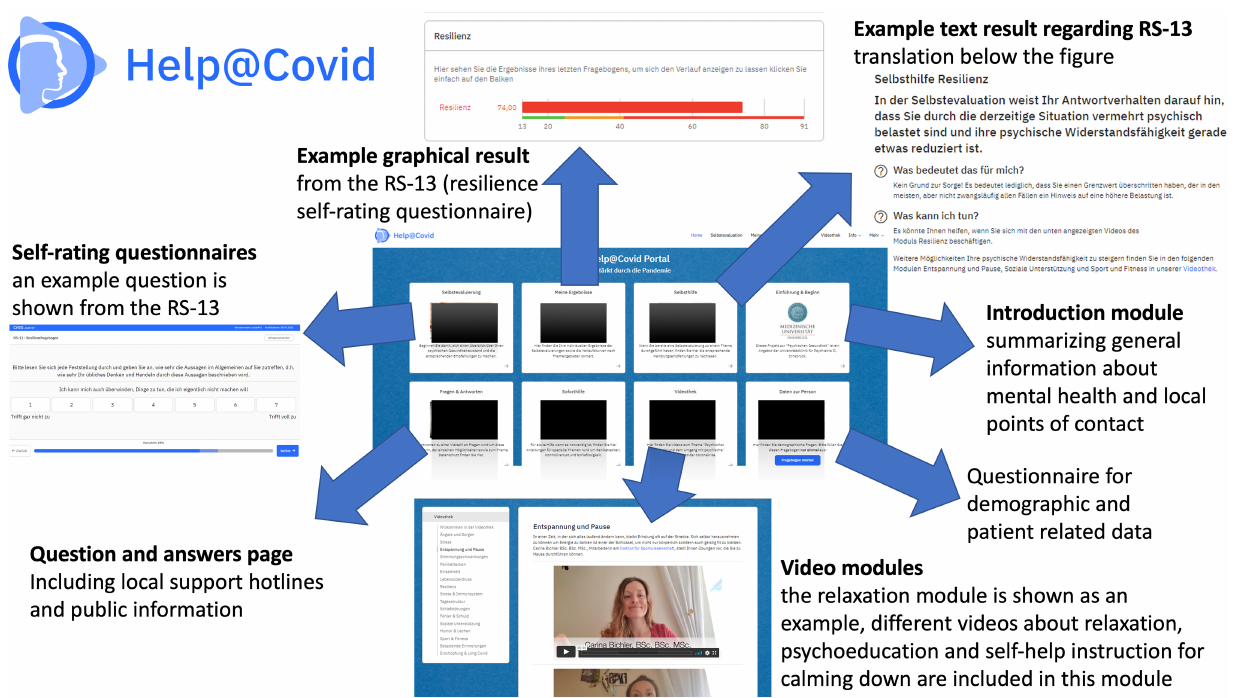
FIGURE 3 | Overview over version 3 of the online self-help mental health platform. The different sections are illustrated with sample screenshots. The translation of the information supplied to explain the personal questionnaire scores in the section “self-help” is as follows: “In the self-evaluation, your responses indicate that you are experiencing increased mental stress due to the current situation. Your resilience could also be reduced now. What does that mean for me? No reason to worry! It just means that your scores in the self-rating questionnaire have exceeded a threshold which can in some individuals be indicative of increased mental stress and burden. What can I do? You might find it helpful to watch the Resilience Module videos below. You can find more ways to increase your mental resilience in the following modules provided on this plaform: relaxation and breaks, social support and sport and fitness.” Other parts are not translated in detail because the screenshots are only used to better illustrate the functioning of the online self-help mental health platform. RS-13, Resiliencescale 13 item version (Leppert et al.,